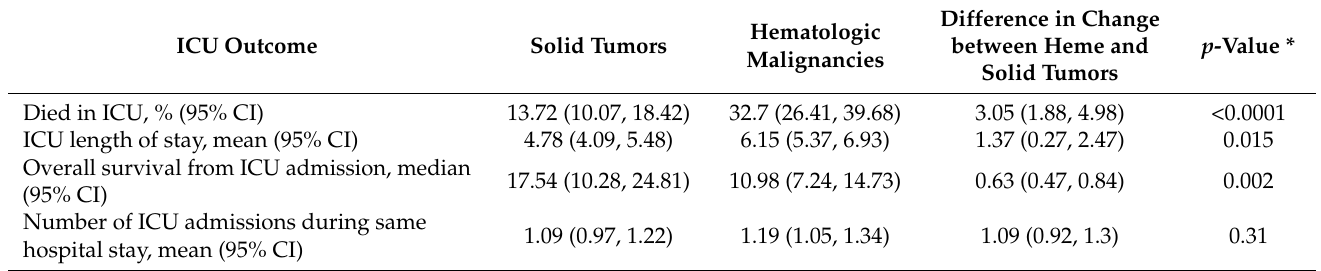
Table 5. Sensitivity analysis accounting for prognosis among patients with solid and hematologic malignancies admitted to ICU in